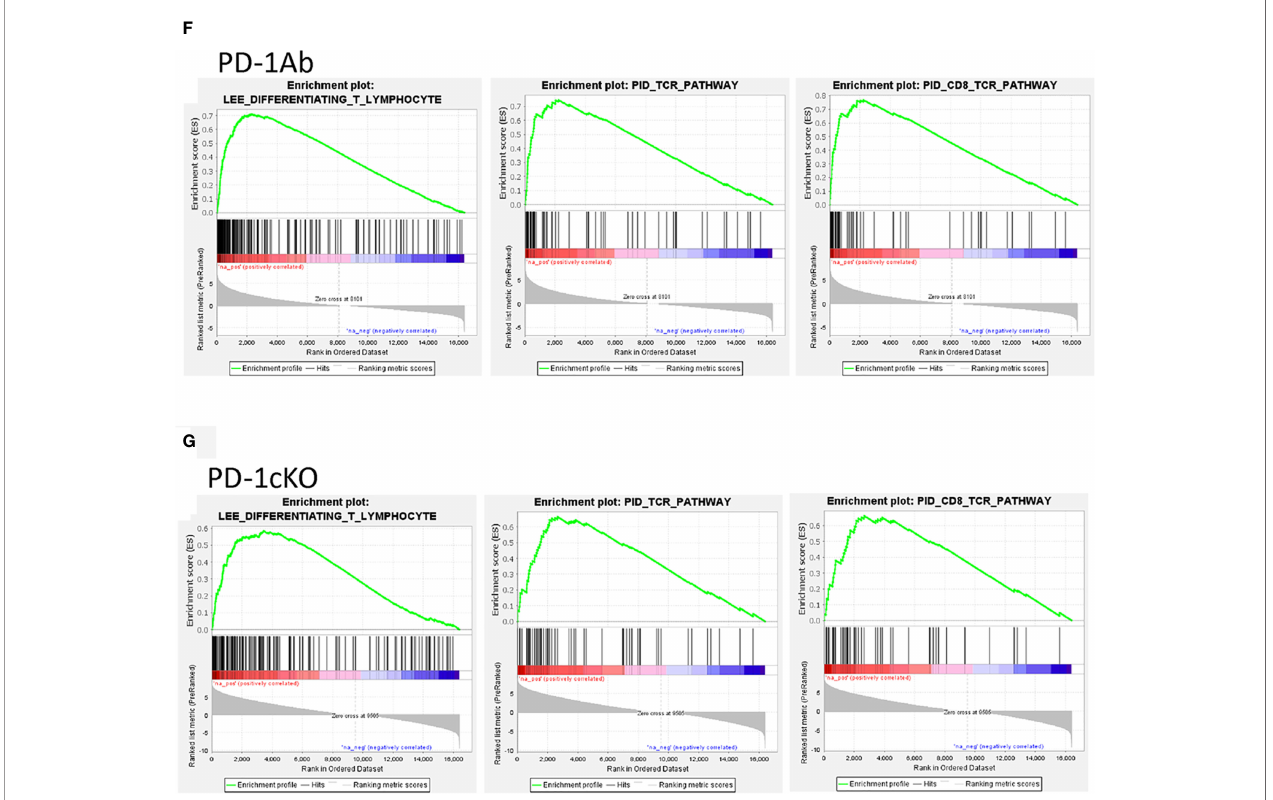
FIGURE 5 | Gene expression pattern from the tumor tissue reveals a common mechanism of immune-mediated tumor regression after antibody blockade or genetic deletion of PD-1 signaling. Gene expression data after RNA sequencing of bulk tumor tissue excised from PD-1 Ab treated (15 days post-implant) or PD-1cKO mice treated with tamoxifen (28 days post-tumor implant). (A) Venn diagram illustrating the number of common (773) and unique genes regulated in PD-1-antibody treated (vs. isotype treated, 47) and PD-1cKO mice (vs. WT mice, 99). (B) Scatter plot showing the 2,184 genes regulated by either PD-1 Ab treated or in PD-1cKO mice, compared to respective controls, with a few genes highlighted. Most genes are upregulated in both comparisons. (C) Speci fi c genes found to be commonly ( CD8a , Tbx21 , Ifng , Klrc1 ) or (D) uniquely ( Gbp2b ) upregulated in the PD-1 Ab-treated and PD-1cKO mice ( Fam20c ) compared to respective controls. No statistical signi fi cance FDR <0.001 between PD-1 Ab treated compared to PD-1cKO, except for Gbp2 (only PD1 antibody treatment) and Fam20c (only PD-1cKO). (E) Ingenuity pathway analysis ® of gene sets of PD-1 Ab-treated and PD-1cKO mice, compared to respective controls, and the intersection of the two (common), showing similarly enriched pathways. (F, G) GSEA analysis showing the top enriched gene sets following either PD-1 Ab treatment or in PD-1cKO mice, compared to respective controls. See also Supplementary Figure S3